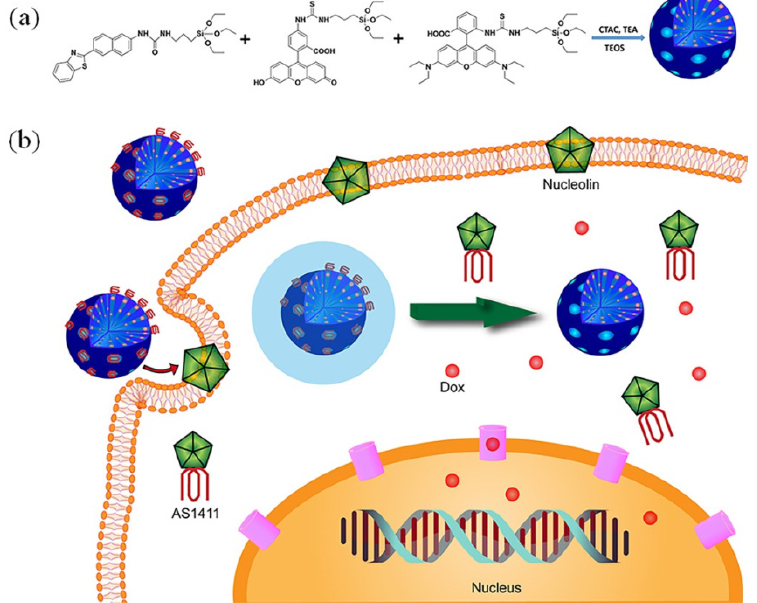
Figure 8. ( a ) Diagram illustrating the synthetic route of MTP–MSNs. ( b ) Design strategy of the